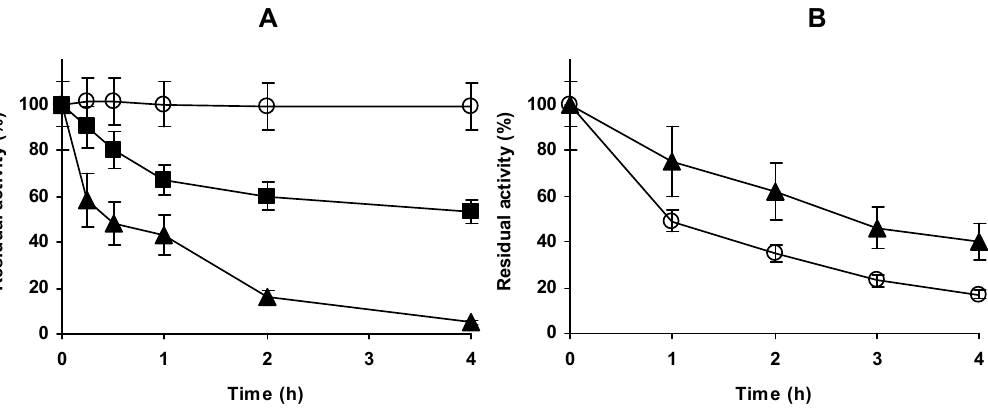
Figure 1. ( A ) Immobilization course of Alcalase in 4% glyoxyl agarose beads. Immobilization was performed at pH 10 and 25 ◦ C as described in methods. Open circles: reference; Solid triangles: supernatant; Solid squares; suspension. ( B ) Inactivation courses of free (open circles) and immobilized (closed triangles) Alcalase. Inactivation was performed at 54 °C and pH 7. Other details are stated in methods section.